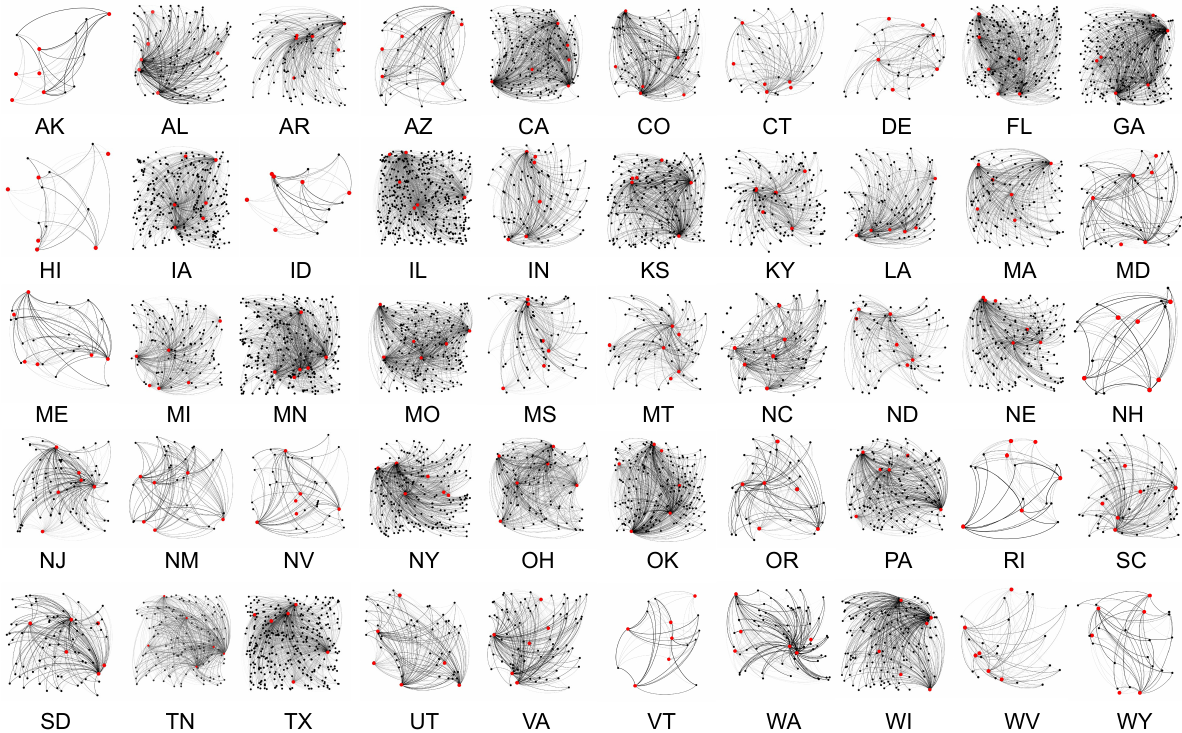
Figure 4. The bilateral bank–asset network of each state in the United States. The black nodes represent banks, the orange nodes represent the six types of assets, and the thickness of each edge is proportional to its